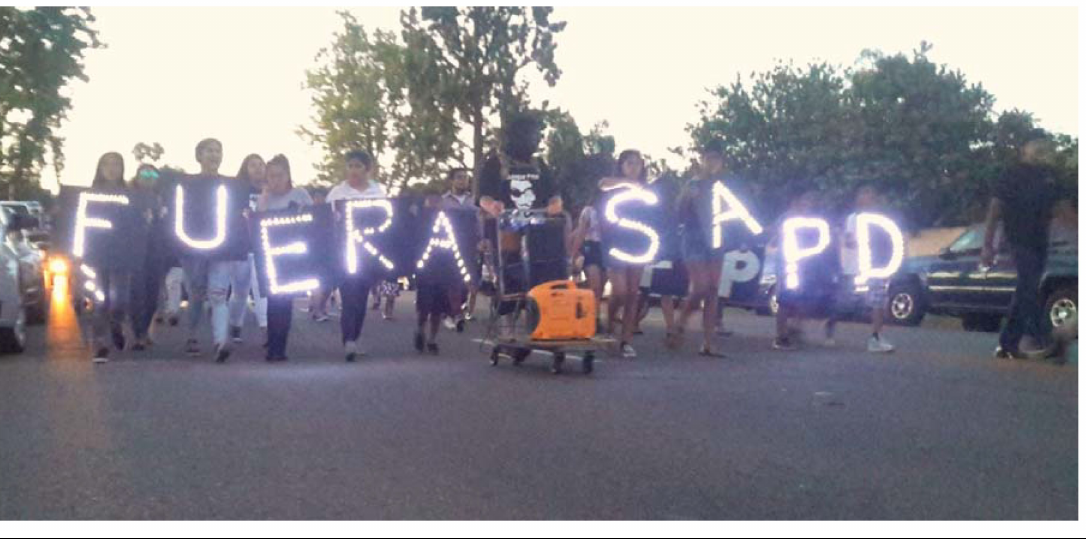
Figure 7. Gang injunction protest in Townsend, 4 August 2015 (Source: James O’Neil Spady).